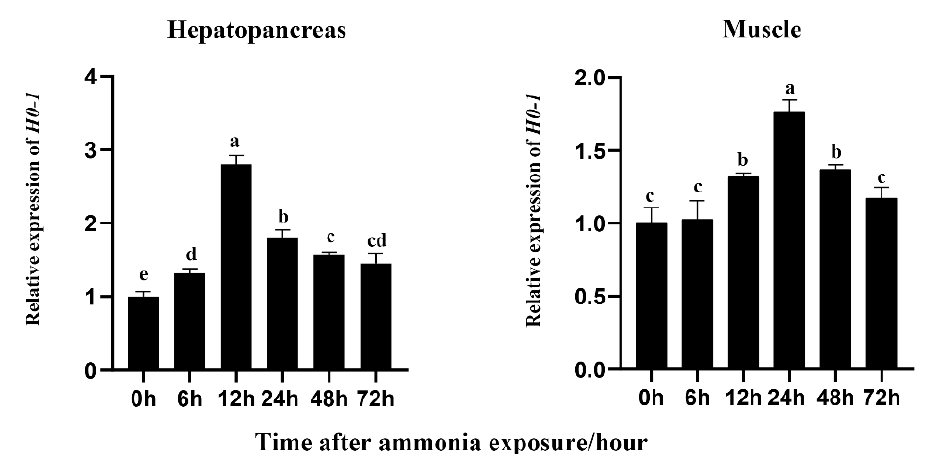
Figure 3. Transcription patterns of Lv-HO-1 in hepatopancreas and muscle at different time points after ammonia-N stress. To determine the relative expression of the other time point, the Lv-HO-1 expression level at 0 hwas set to 1.00. All values are the mean ± SD, n = 3. Different letters denote a significant difference ( p < 0.05).